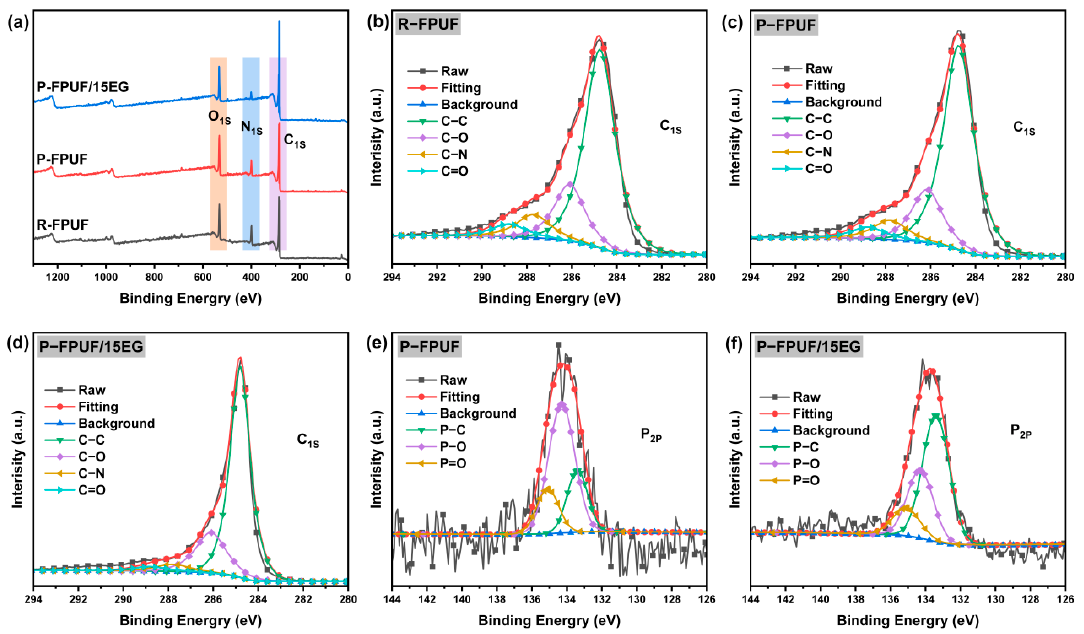
Figure 12. The XPS survey spectra of char residue for R-FPUF, P-FPUF, and P-FPUF/15EG ( a ), high- resolution XPS spectra of C1s for the R-FPUF ( b ), P-FPUF ( c ), and P-FPUF/15EG ( d ) char samples, high-resolution XPS spectra of P2p for the P-FPUF ( e ), and P-FPUF/15EG ( f ) char sam-ples. Table 4. Elemental composition and content of residual char.